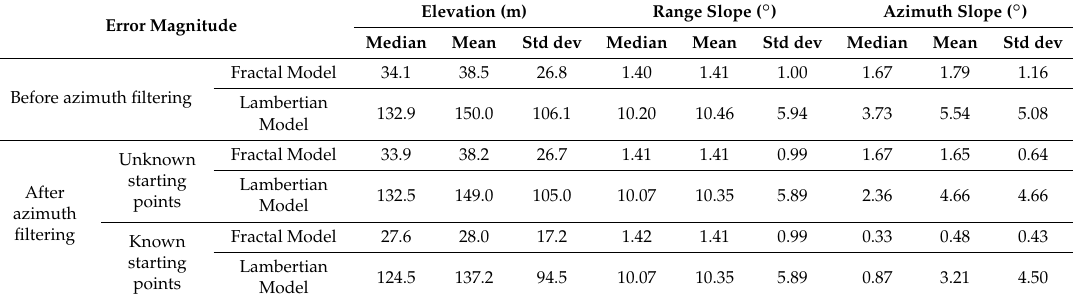
Table 2. Quality measures for the sinusoidal DEM: speckle case.